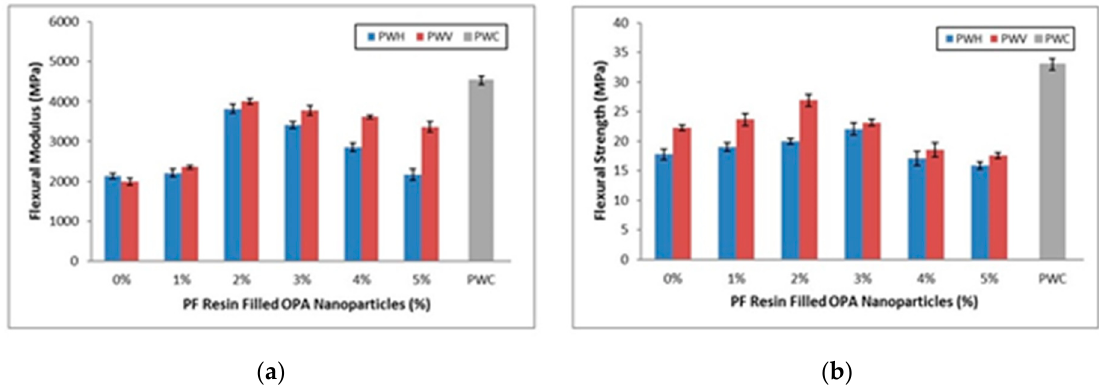
Figure 7. a ) Flexural modulus and b ) flexural strength of PWV and PWH with different loading of PF filled OPA nanoparticles compared to